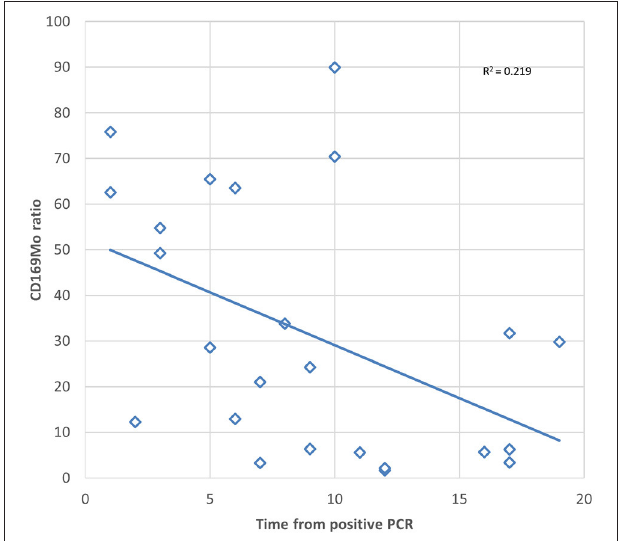
FIGURE 2 | Scatter plot showing the correlation between CD169Mo ratio and time in days from positive PCR of SARS-CoV-2.